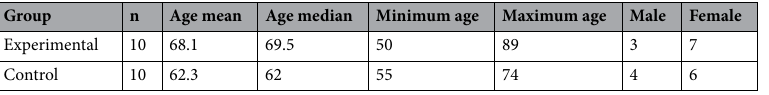
Table 3. Baseline patient characteristics by ramdomization arm.